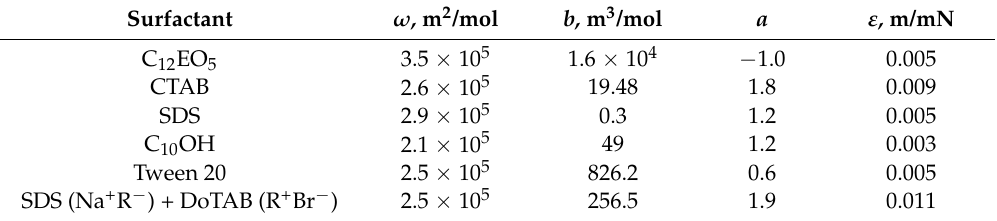
Table 1. Model parameters used for fitting of experimental data by the Frumkin adsorption